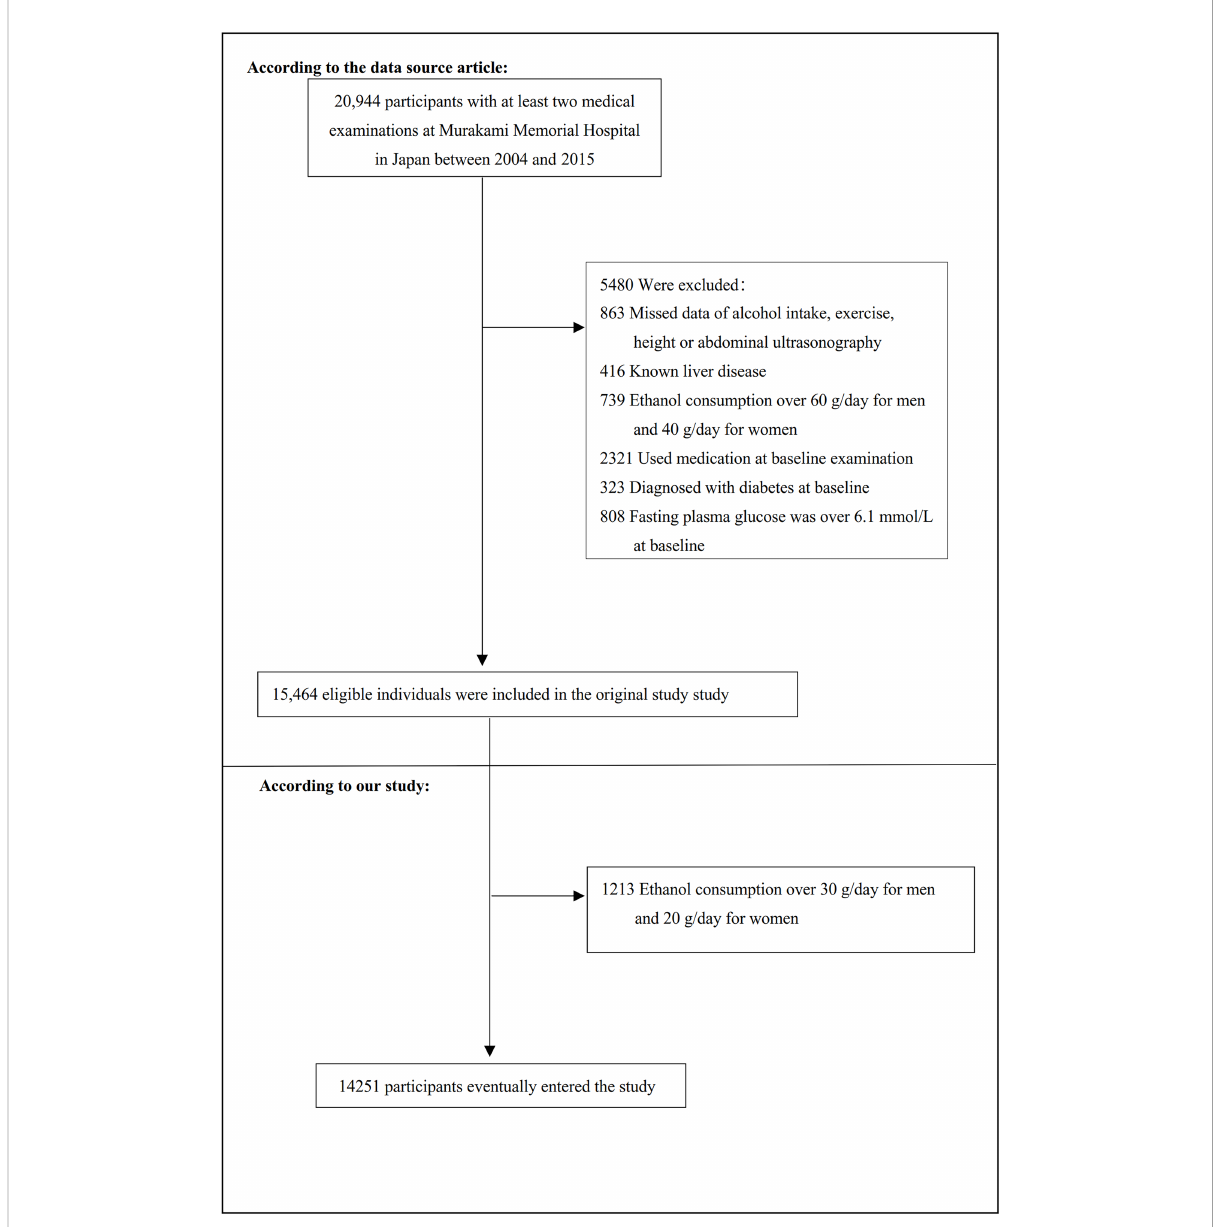
FIGURE 1 Flowchart of study participants. Figure 1 showed the inclusion of participants. The eligibility of 15,464 participants was assessed in the original study. We excluded patients with ethanol consumption over 30 g/day for men and 20 g/day for women (n=1213). The fi nal analysis included 14251 subjects in the present